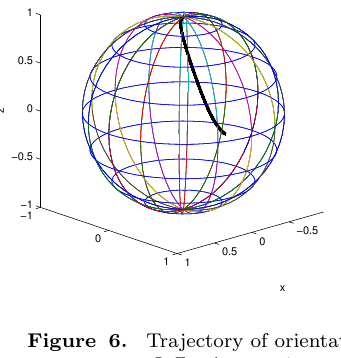
Figure 6. Trajectory of orientation vector, Jeffery’s equation.